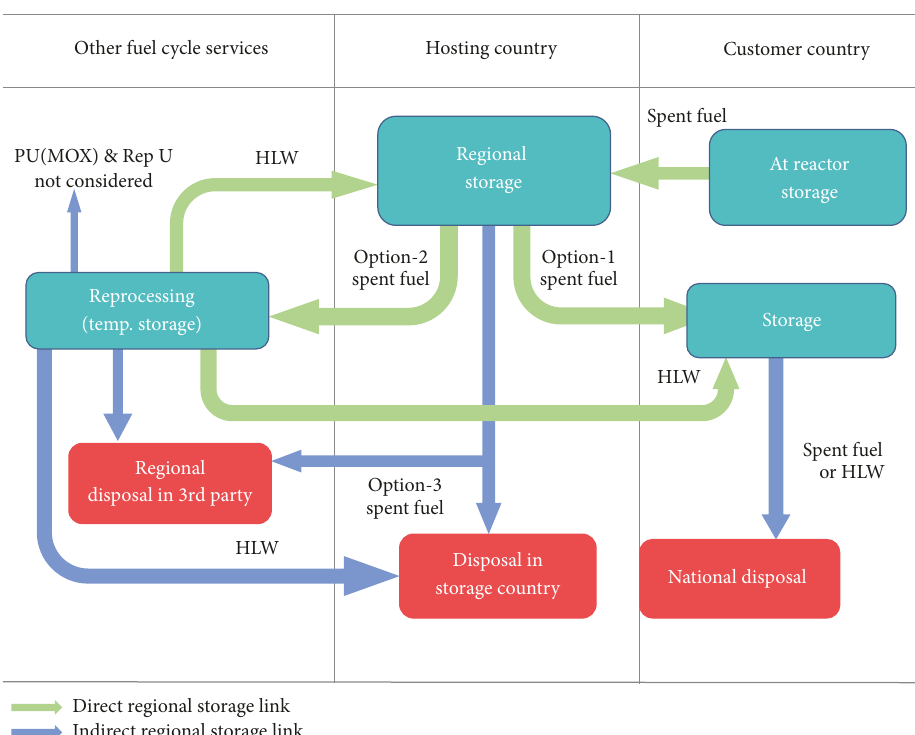
Figure 2: A regional SNF storage system and possible service options derived from